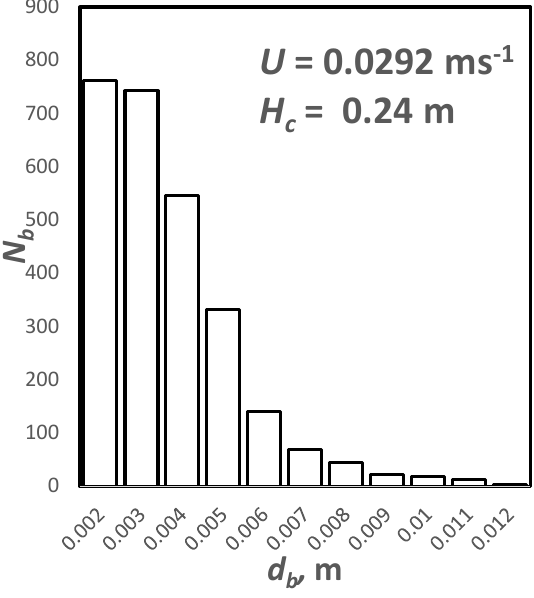
Figure 11. BSD at U = 0.0292 ms -1 and H c = 0.24 m.